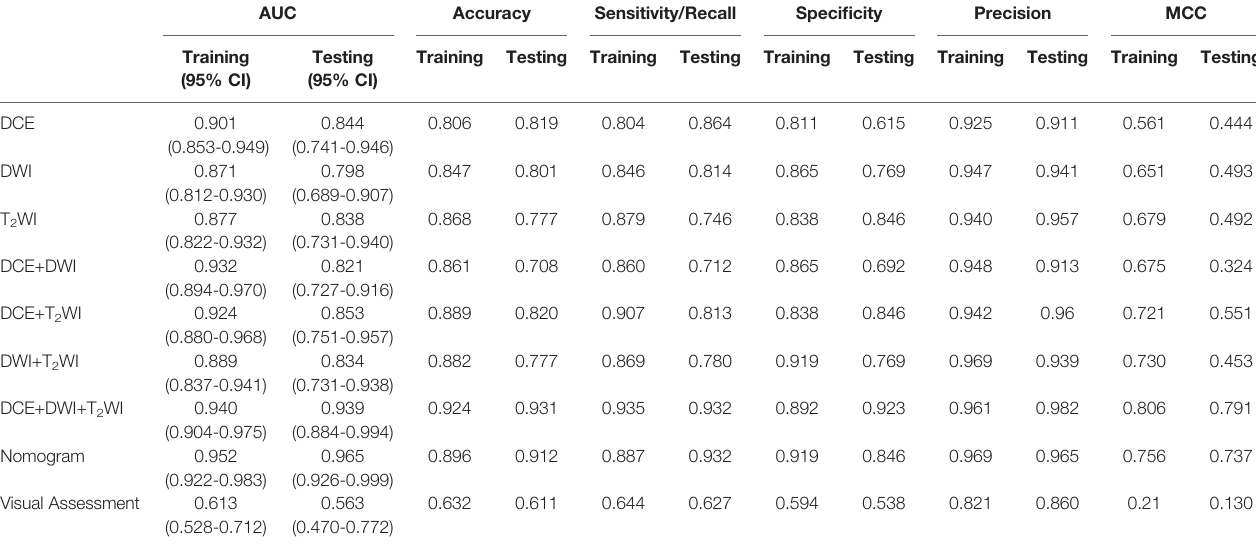
TABLE 3 | Results of the radiomic models and the models based on the nomogram and visual assessment.